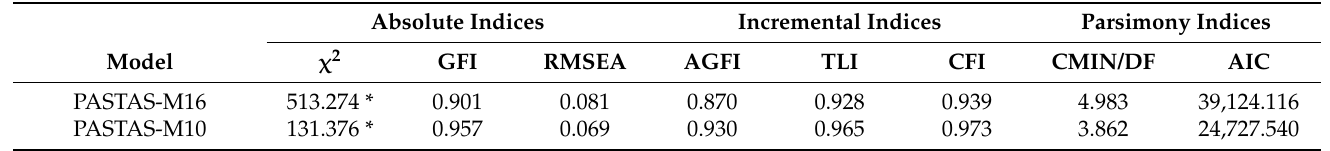
Table 3. Fit indices for models PASTAS-M16 and